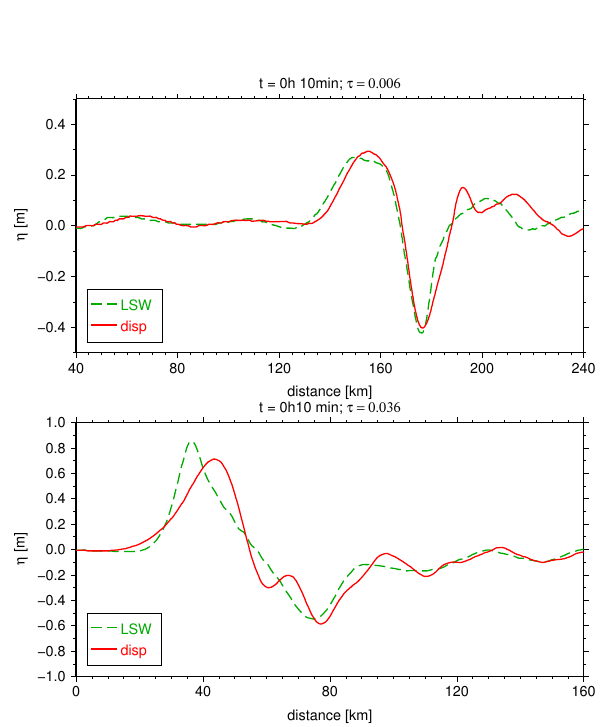
Fig. 11. Effect of dispersion for an earthquake along the Hellenic Arc. In the upper panel the surface elevations extracted along a side- wise transect are shown. In the lower the transect is taken ahead of the earthquake.